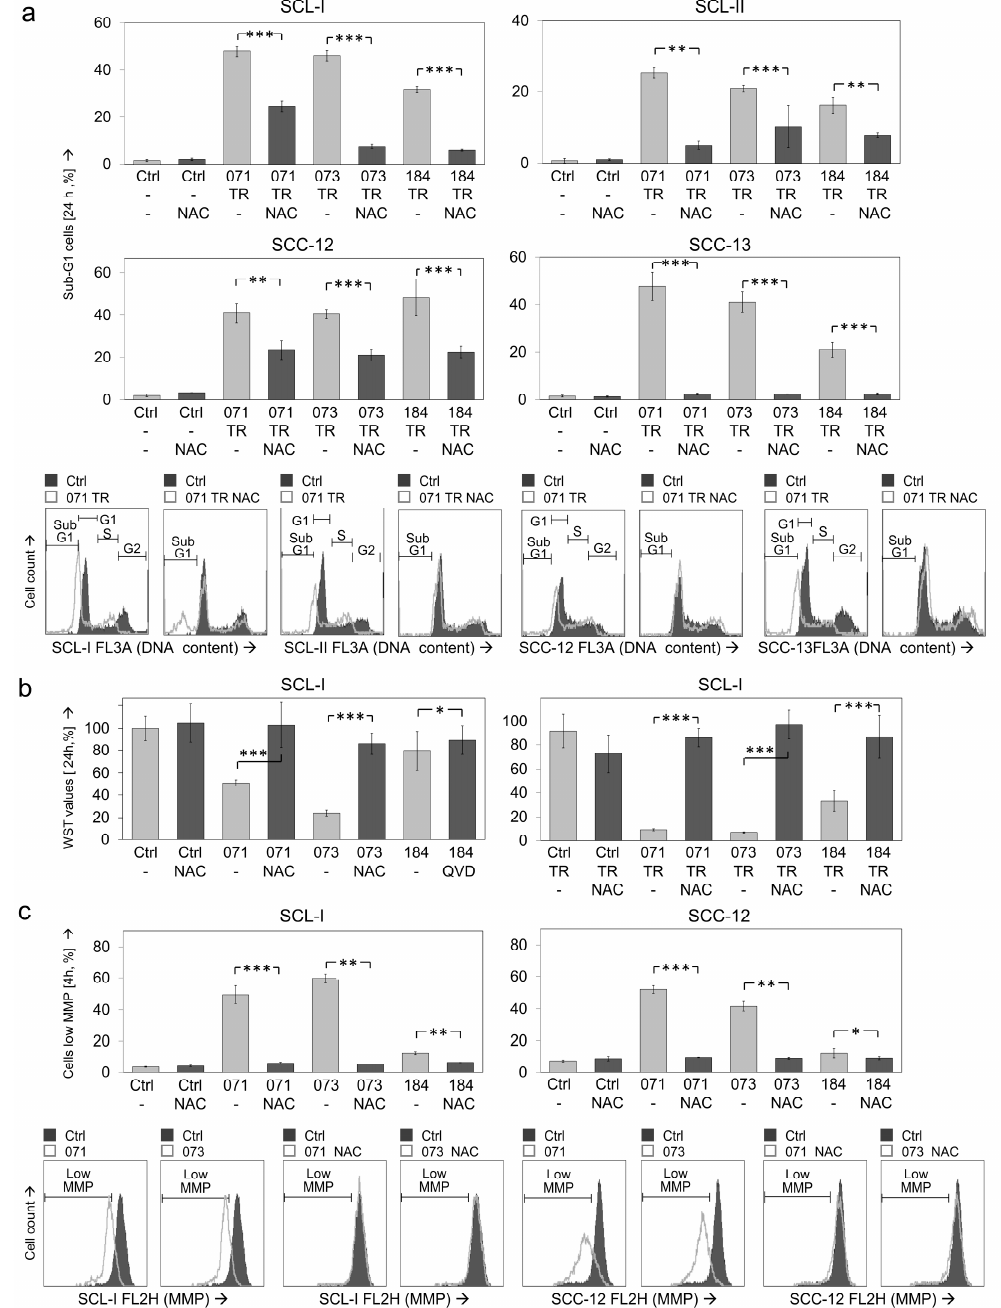
Figure 8. Effects of NAC on apoptosis, cell proliferation and MMP. The antagonistic effects of the antioxidant N- acetylcysteine (NAC, 1 mM, 1 h pretreatment) were investigated. Cells were treated with combinations of indirubins (DKP-071, -073 and -184, 10 µ M) and TRAIL (TR; 50 ng/mL) or with indirubins alone, as indicated. ( a ) Apoptosis was determined at 24 h by cell cycle analysis and quantification of sub-G1 cells in four cSCC cell lines. ( b ) Cell proliferation was quantified by WST-1 assay in SCL-I at 24 h. ( c ) Loss of MMP was investigated in SCL-I and SCC-12 at 4 h of treatment. ( a , c ) Examples of flow cytometry measurements are provided below (overlays of treated cells vs. controls). ( a – c ) Bar charts, mean values and SDs are shown of a representative experiment. Two independent experiments were performed, each one with triplicates. Asterisks indicate statistical significance, when cells ± NAC were compared (* p < 0.05; ** p < 0.01; *** p <